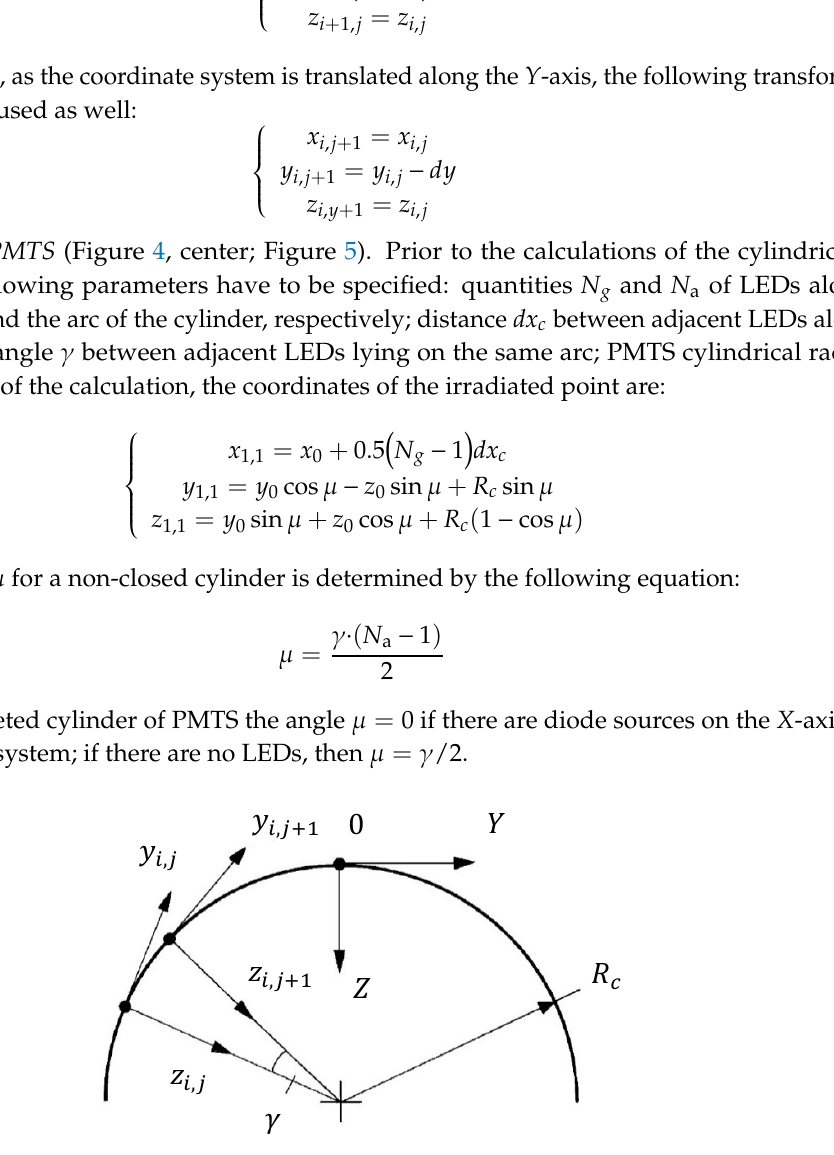
Figure 5. Schematics with main parameters for calculation of cylindrical PMTS.